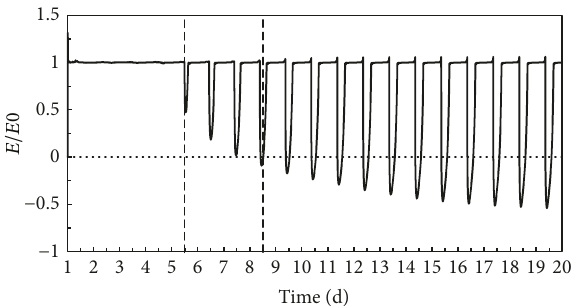
Figure 3: The temporal variation of ratio of actual evaporation rate ( 𝐸 ) and potential ( 𝐸 0 ) rate 𝐸/𝐸 0 during the simulation period.